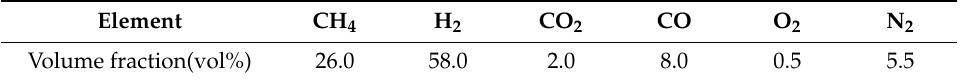
Table 5. Composition of coke oven